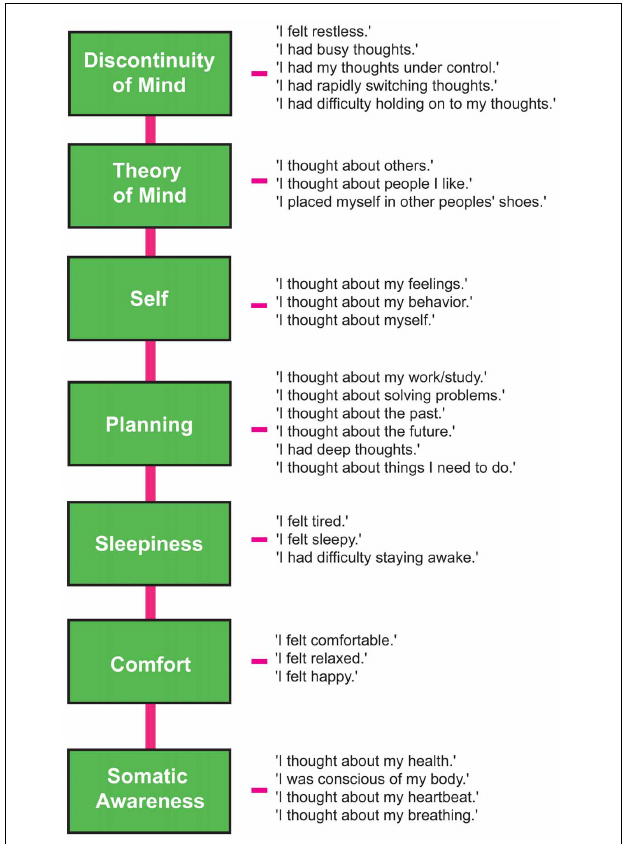
FIGURE 2 | The Amsterdam Resting-State Questionnaire reveals seven dimensions of resting-state cognition. The factor analysis of the variance-covariance structure of the data from the self-report ARSQ ( n = 813) resulted in seven factors, which we labeled as shown in the green boxes. A total of 27 items were included in the final model and the individual items belongingto each factor are listed to the right (the CFA path diagram is shown in Figure 1